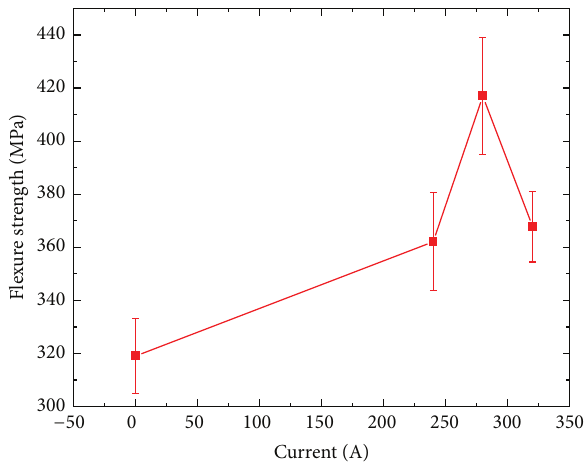
Figure 11: Residual strengths of ZSB materials at different current